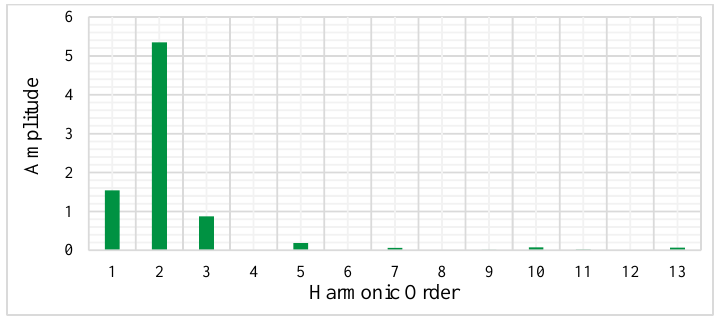
Figure 2. Harmonic contents in the MMF.